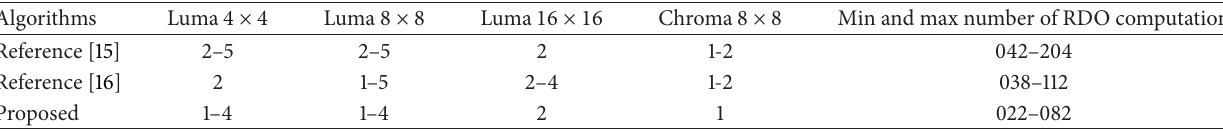
Table 1: Comparison of the number of candidate modes.